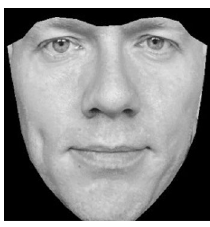
Figure 4. Illustration of male photo with background removed.